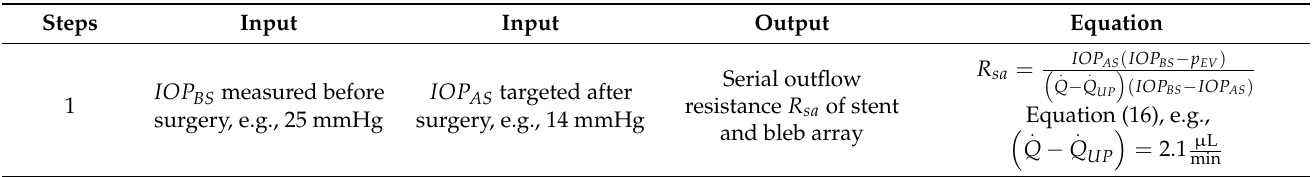
Table A1. The step-by-step procedure for personalized stent